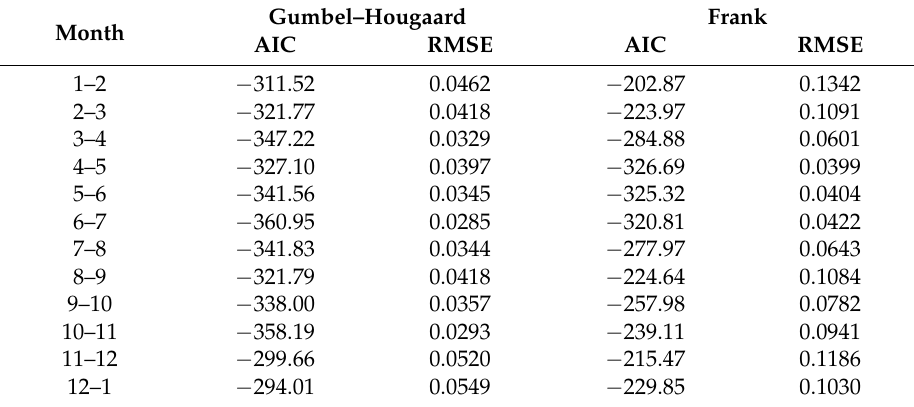
Table 4. Comparison of Akaike information criterion (AIC) and RMSE values for joint distribution of different streamflow pairs. Gumbel–Hougaard